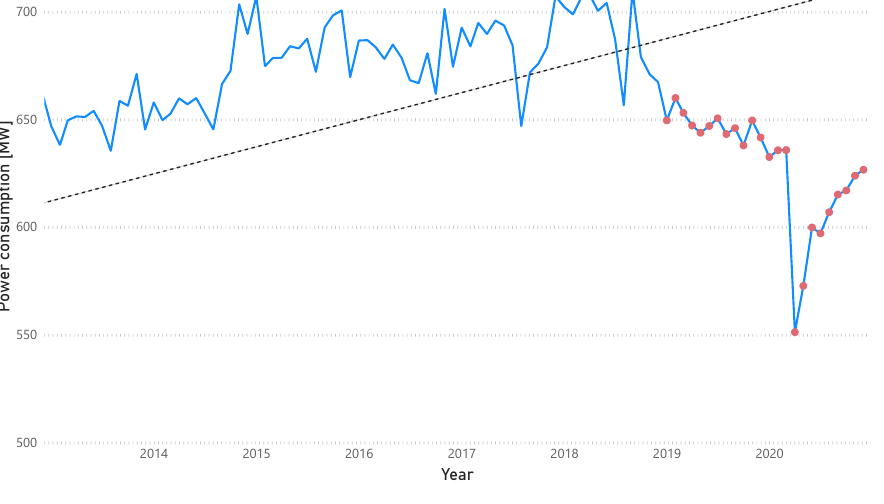
Figure 2. Monthly power consumption in Quito, Ecuador between January 2013 and December